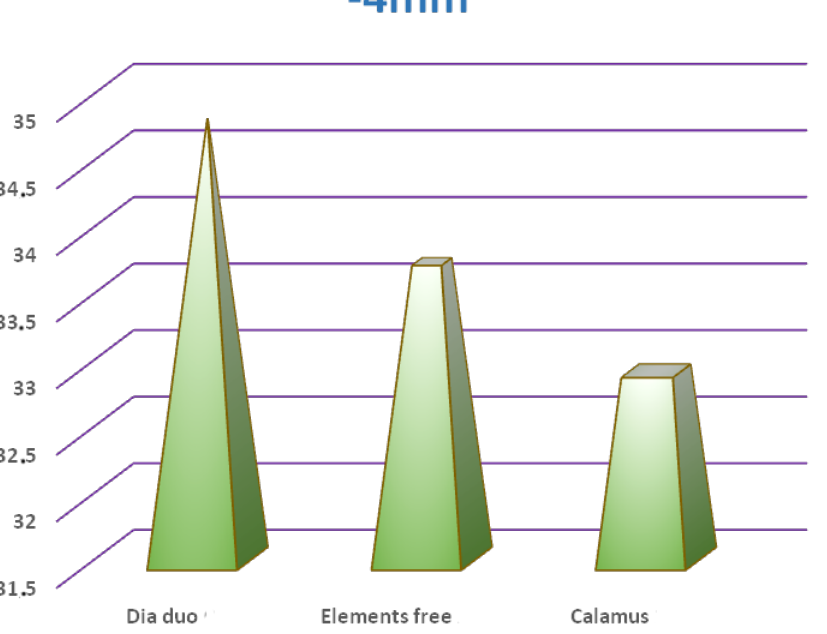
Figure 6. Average temperatures at − 4 mm of the three systems compared. The data show no statistically significant differences ( p = 0.620).